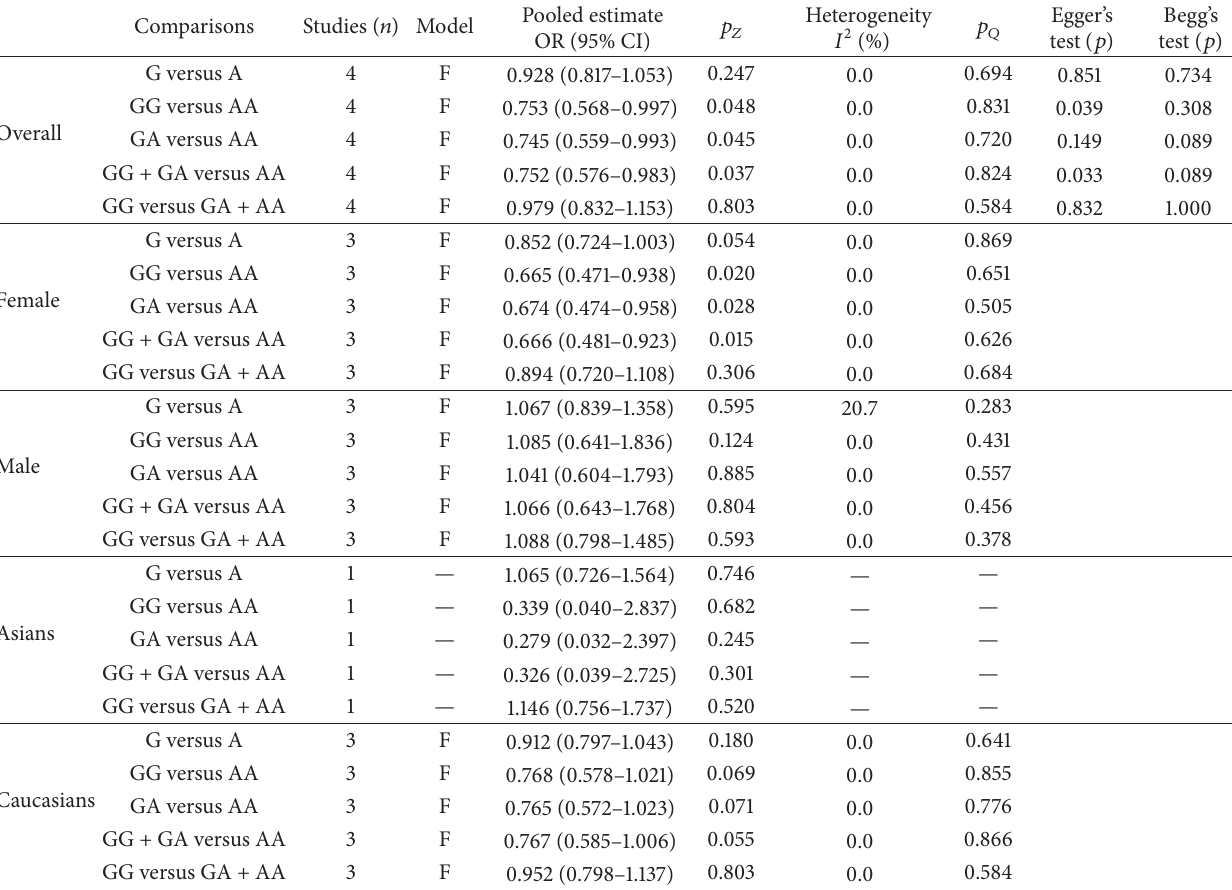
Table 4: Summary risk estimates for association between eNOS rs1799983 and